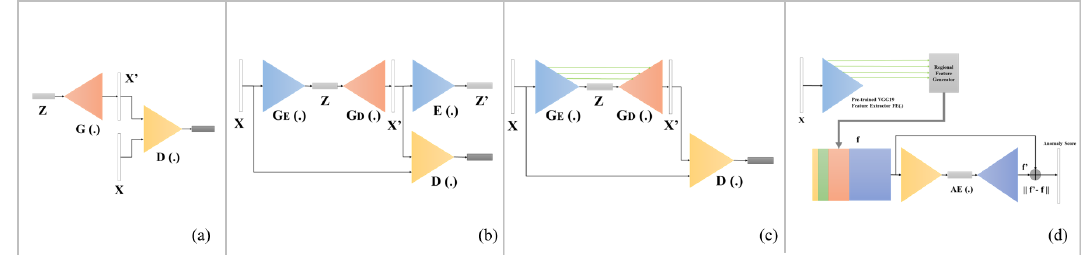
Figure 1. Architectures of: ( a ) AnoGAN, ( b ) GANomaly, ( c ) Skip-GANomaly, and ( d ) DFR.